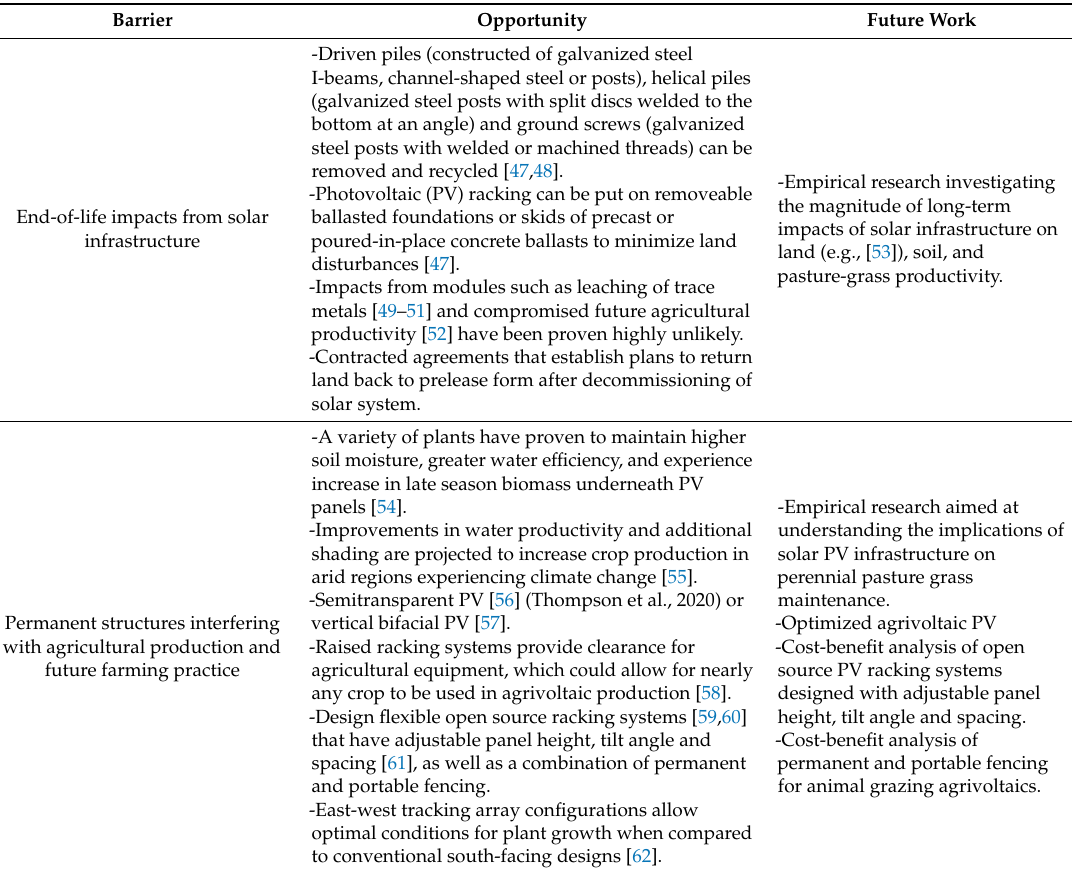
Table 2. Barriers, opportunities, and directions for future work regarding the di ff usion of agrivoltaics. Barrier Opportunity Future